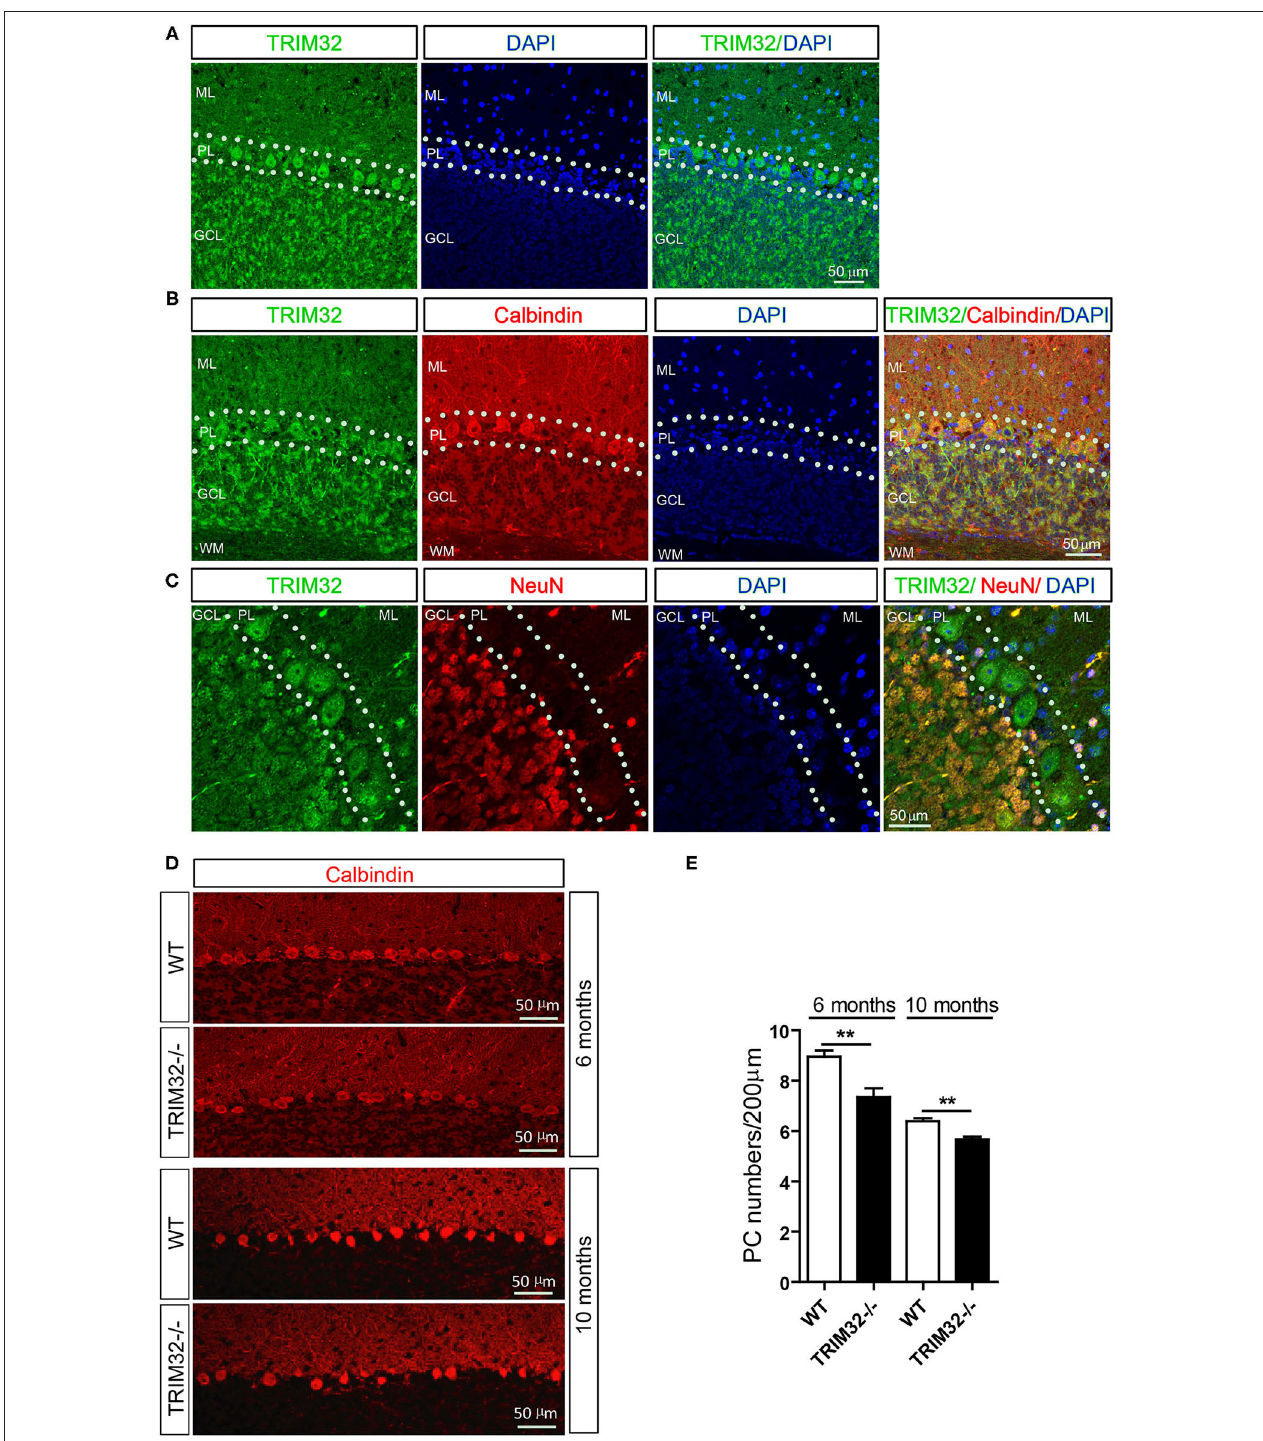
FIGURE 4 | TRIM32 is highly expressed in cerebellar PCs and absence of TRIM32 decreases the number of PCs. (A) Cerebellar sagittal sections were stained with specific antibodies against TRIM32. (B) Cerebellar sagittal sections were co-stained with antibodies against TRIM32 and calbindin. (C) Cerebellar sagittal sections were co-stained with antibodies against TRIM32 and NeuN. (D) PCs in the cerebellar sagittal sections were stained with antibodies against calbindin both in 6 months and 10 months old mice. (E) The number of PCs was quantified. Scale bar = 50 µ m. Data are presented as mean ± SEM. n = 5 mice/genotype. ** p < 0.01. ML, molecular layer; PL, Purkinje cells layer; GCL, Granule cells layer; WM, White matter.